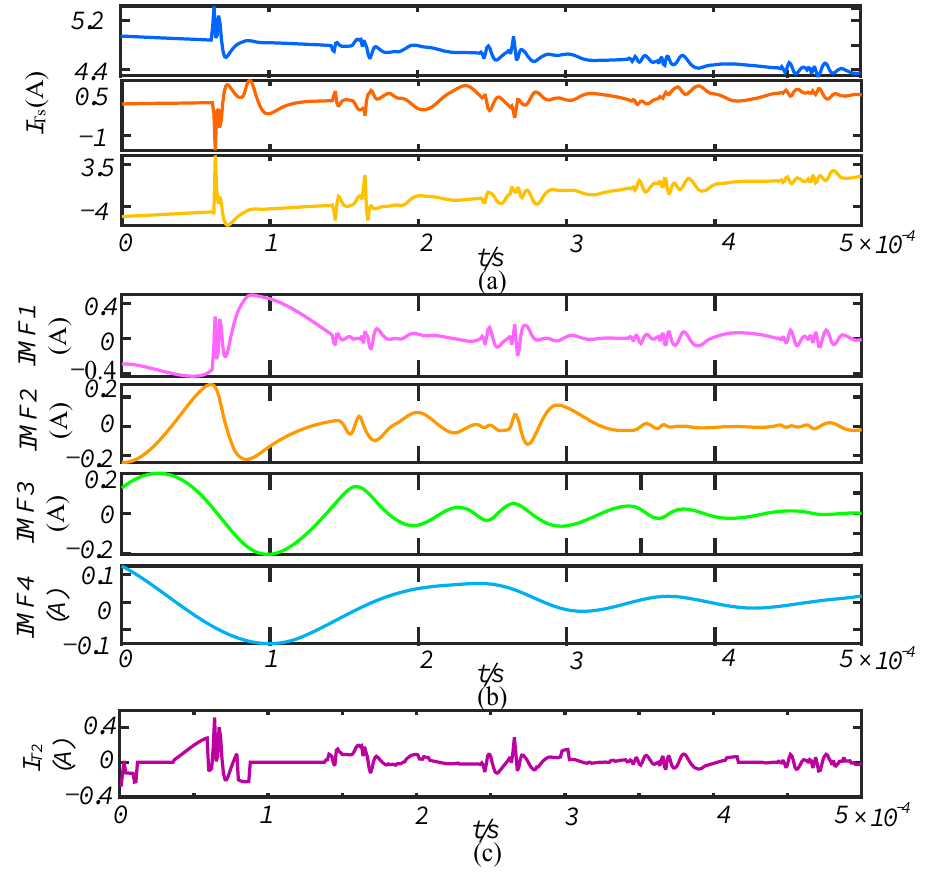
Figure 11. Analysis diagram of counterattack non ‐ flashover waveform and improved HHT signal.